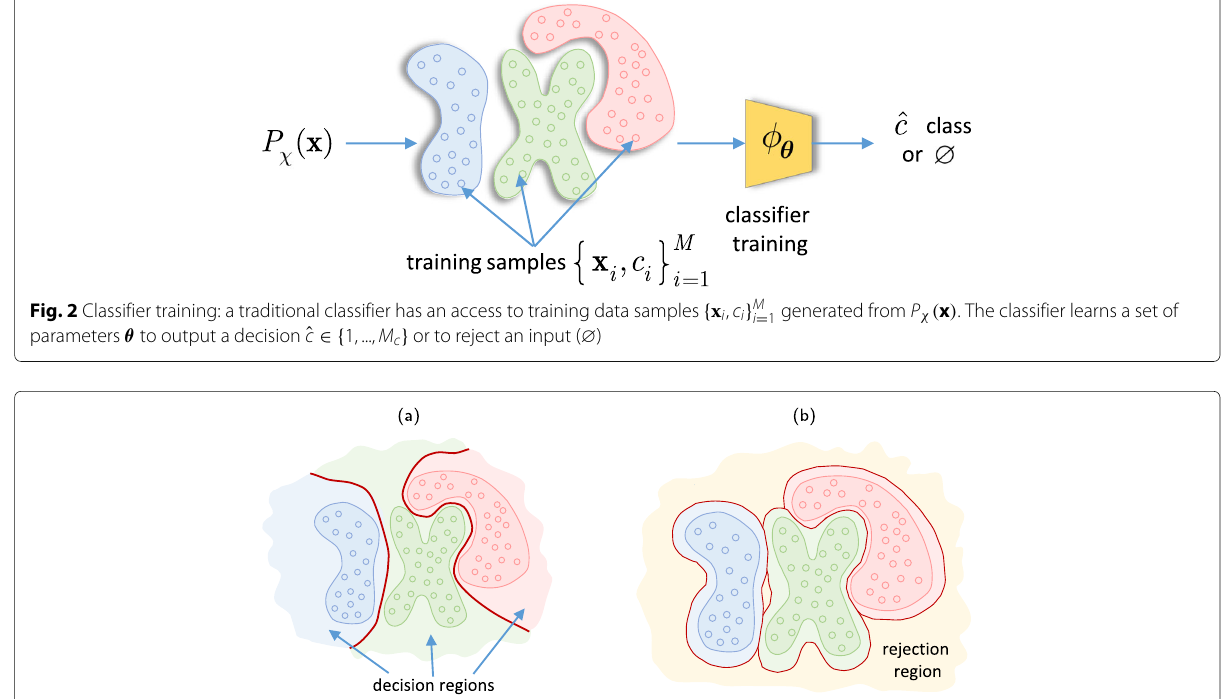
Fig. 3 Classifier’s decision boundaries: a without rejection and b with rejection. Note the difference in the decision regions of trained classifiers